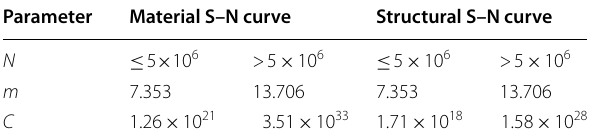
Table 3 Parameters of S–N curves of the material A357-T6 and